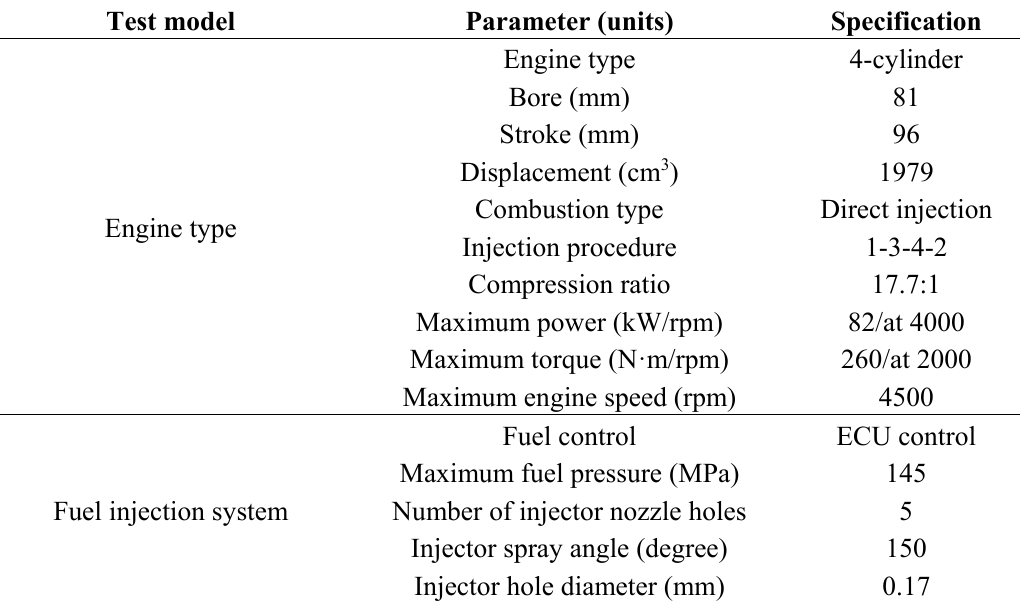
Table 3. Specifications of the test